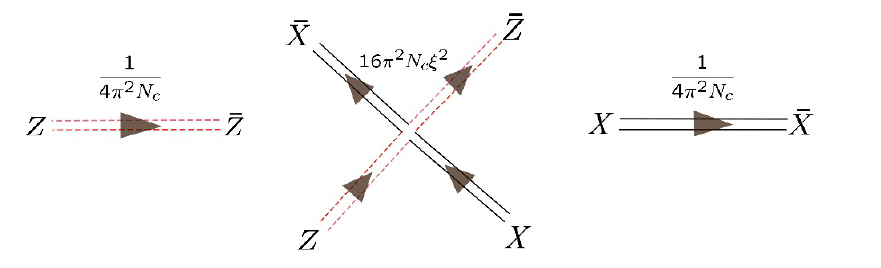
Figure 2 . Feynman